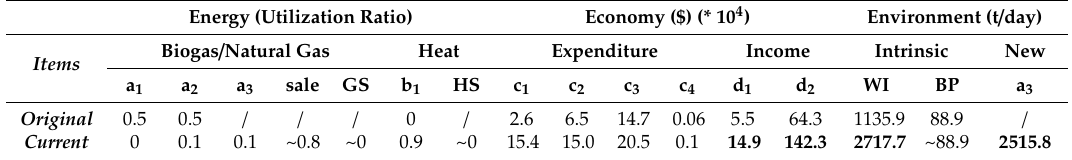
Table 4. Benefit comparison of the